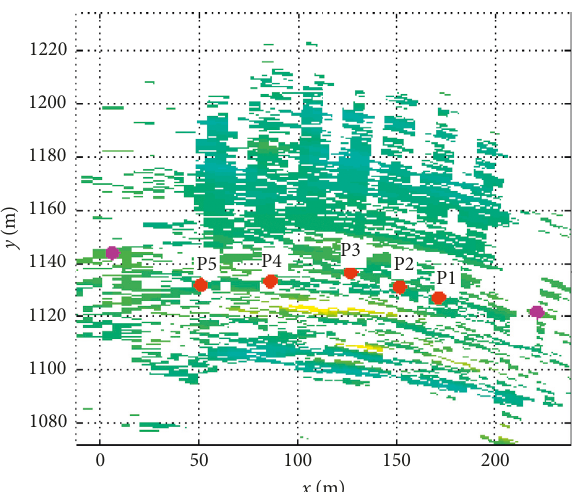
Figure 17: Contour curve of the top of the dam.